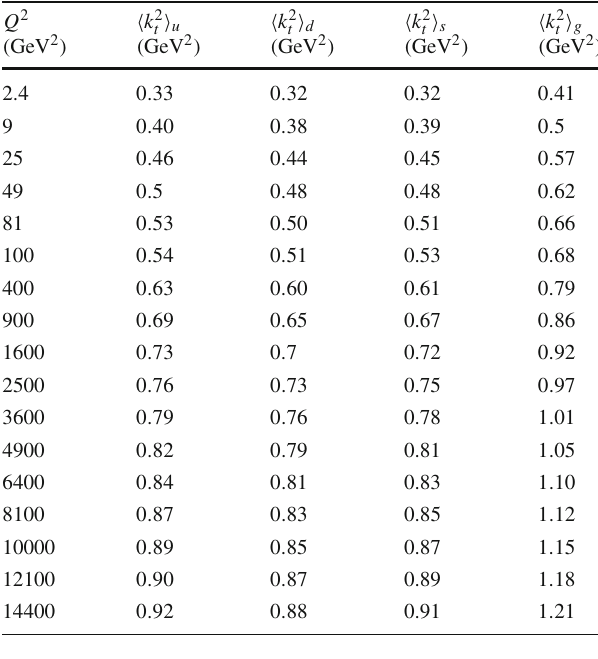
Table 1 The values of average transverse momentum for the light quarks and gluon in the hard scales Q 2 = 2 . 4 to 1 . 44 × 10 4 GeV 2